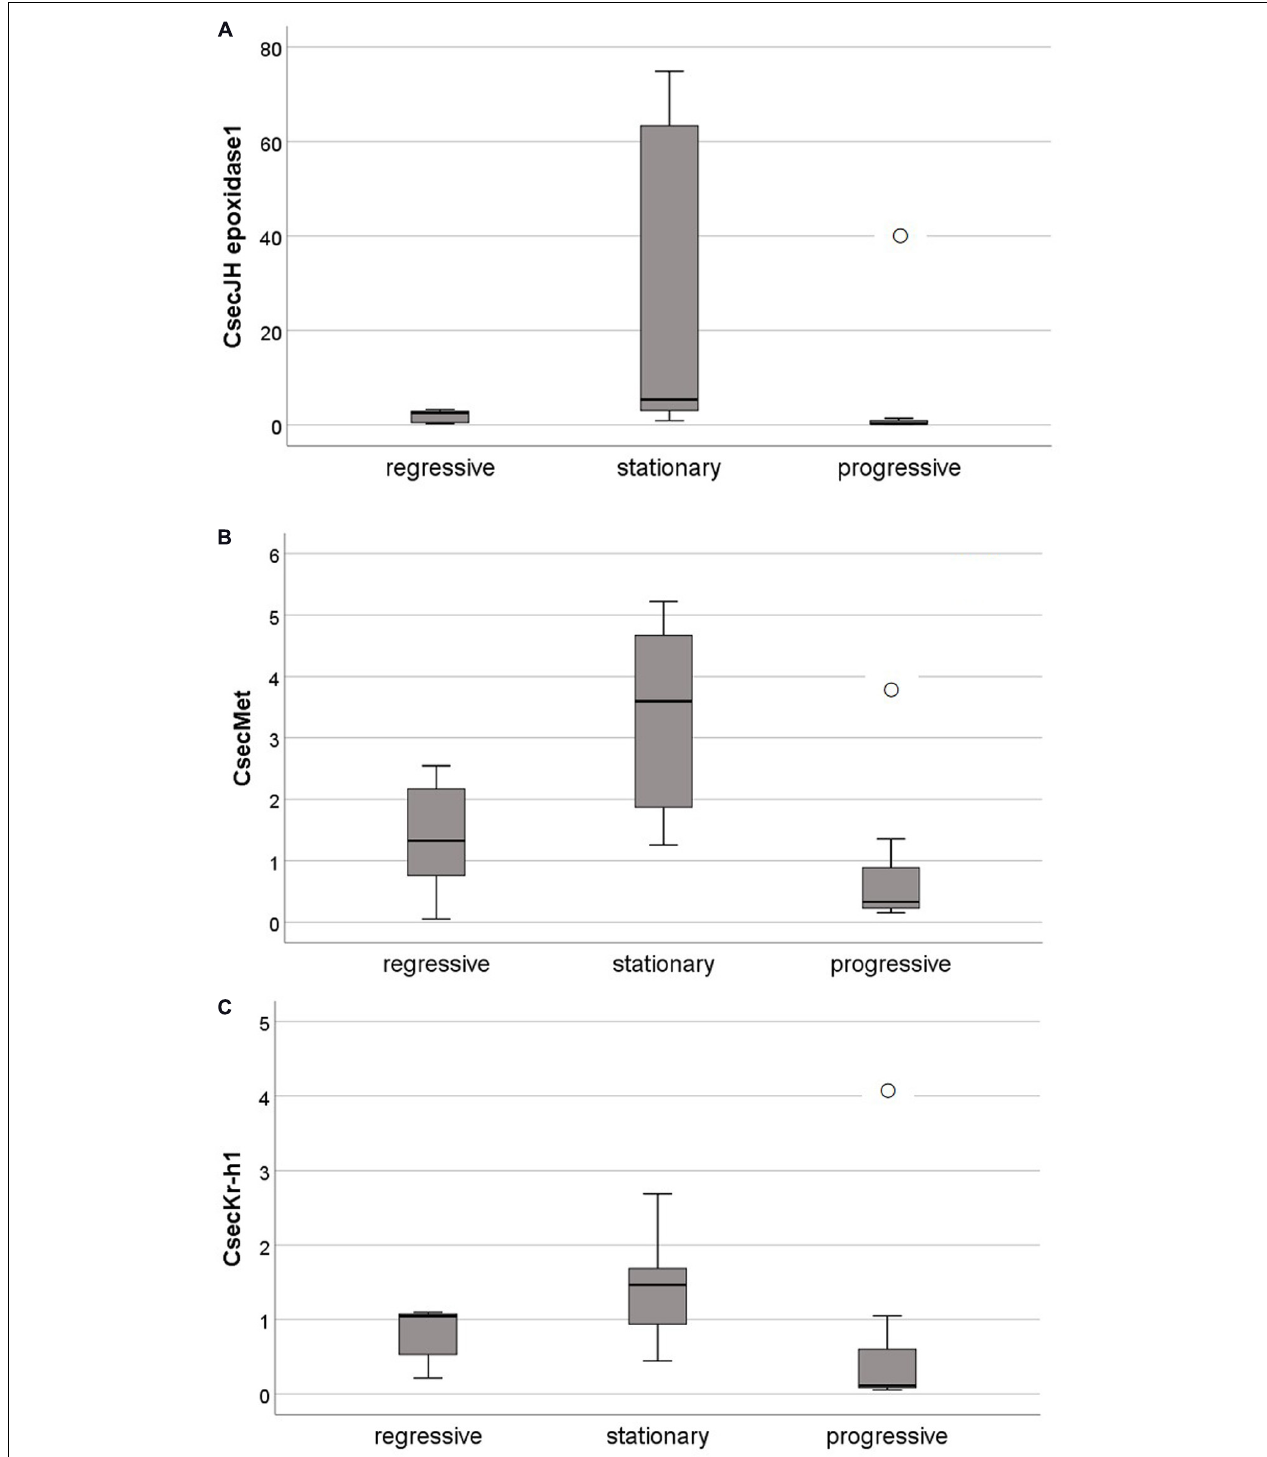
FIGURE 5 | Relative expression of genes related to JH biosynthesis and JH signaling after a molt, in relation to molting types. All shown genes were significantly (by trend for CsecKr-h1 ) higher expressed after stationary than progressive and regressive molts. (A) CsecJH epoxidase1 , a genes supposed to catalyze the last step of JH biosynthesis. (B) CsecMet , the 1:1 ortholog of met from the cockroach Blattella germanica whose protein functions as receptor of JH. (C) CsecKr-h1, the 1:1 ortholog of Kr-h1 in D. melanogaster and B. germanica which functions as early response gene of JH signaling. Shown are boxplots with median, quartiles, minimal and maximal values, and outliers (open circle), the later are cases that have values at least three times the height of the boxes.